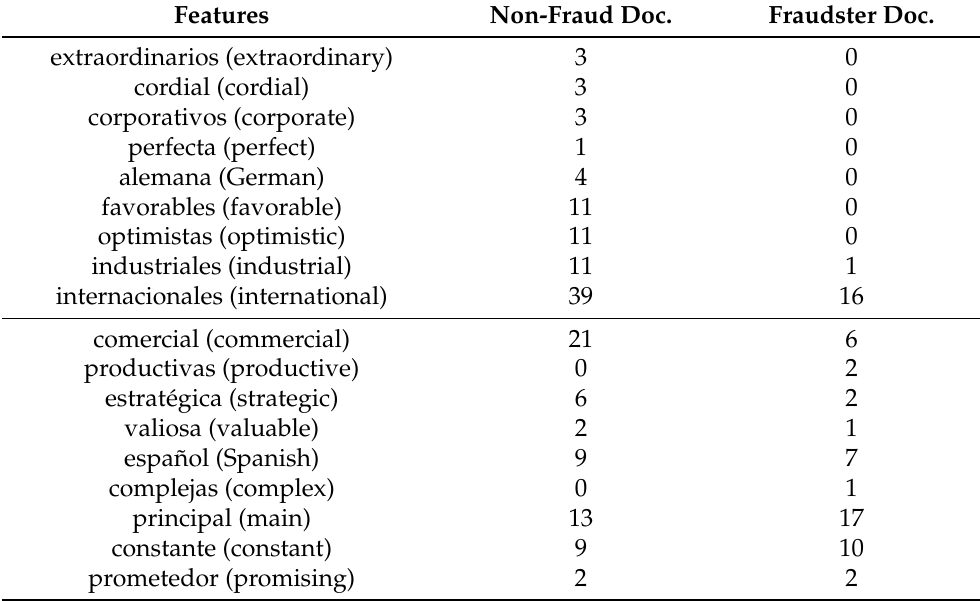
Table 6. Sample of more/less weighted adjectives and occurrences in